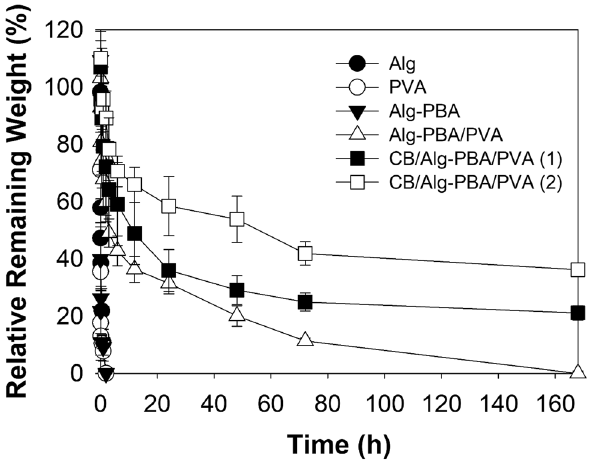
Figure 5. Relative remaining weight of Alg, PVA, Alg-PBA, Alg-PBA/PVA hydrogels, and CB/Alg-PBA/PVA hydrogels containing 1 or 2 mg CB at a predetermined time interval.